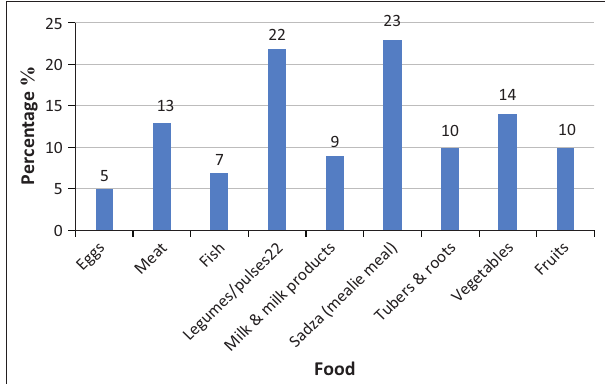
FIGURE 2: Variety of food eaten on a daily